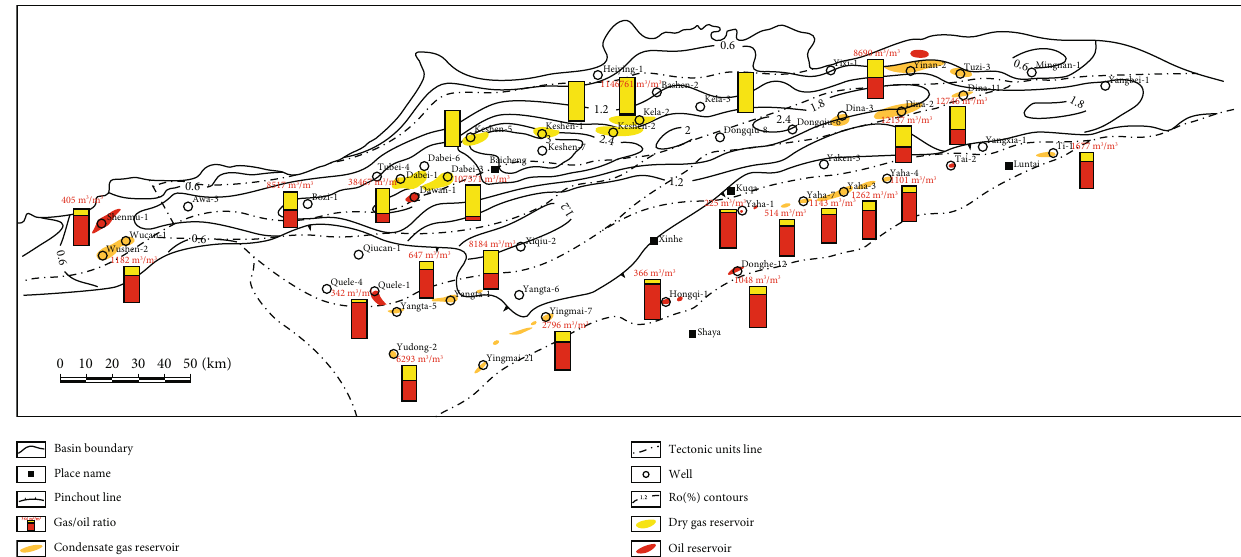
Figure 5: Congruency map of the oil and gas phase state and the source rock Ro in the Kuqa foreland